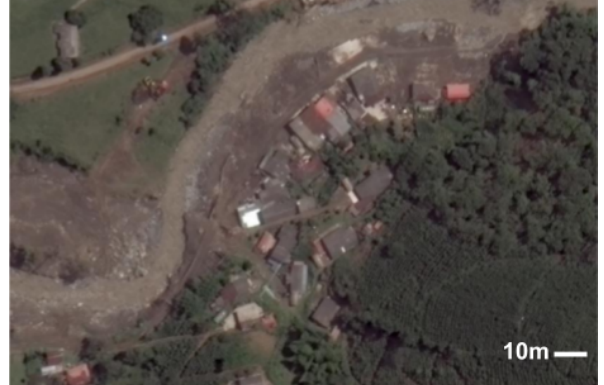
Figure 1. Example of infrastructure damage as a result of the La Liboriana flash flood event on 18 May 2015. (a) Aerial photo- graph taken before the event (2012), during a mission of the De- partment of Antioquia’s government, and (b) a satellite image af- ter the event (courtesy of CNES/Airbus via © Google Earth). The images show the destruction of most houses in that particular com- munity, a bridge over La Liboriana, and the main road. All of the houses shown in the 2015 image had to be either demolished or structurally repaired. The images also show changes in the delin- eation of the main channel as well as considerable erosion in the river